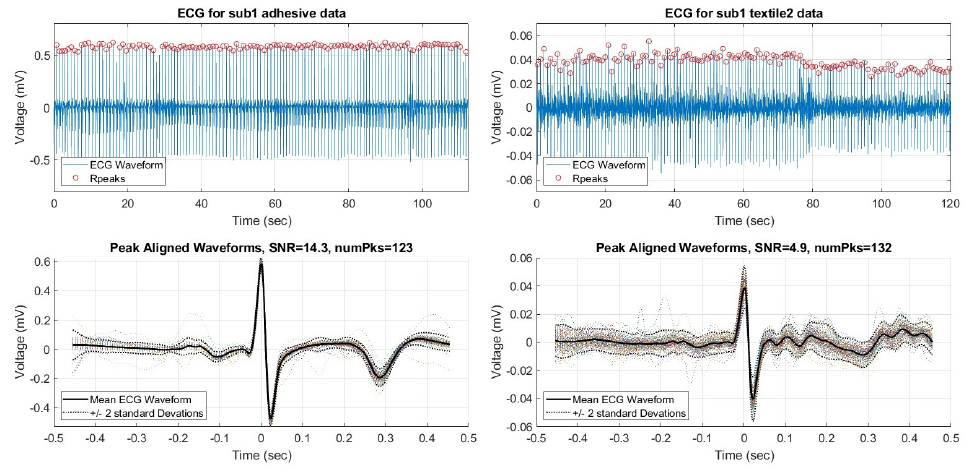
Figure 4. Time domain ECG data for subject 1 ( top ), collected using adhesive electrodes, and the corresponding Mean ECG waveform ( bottom